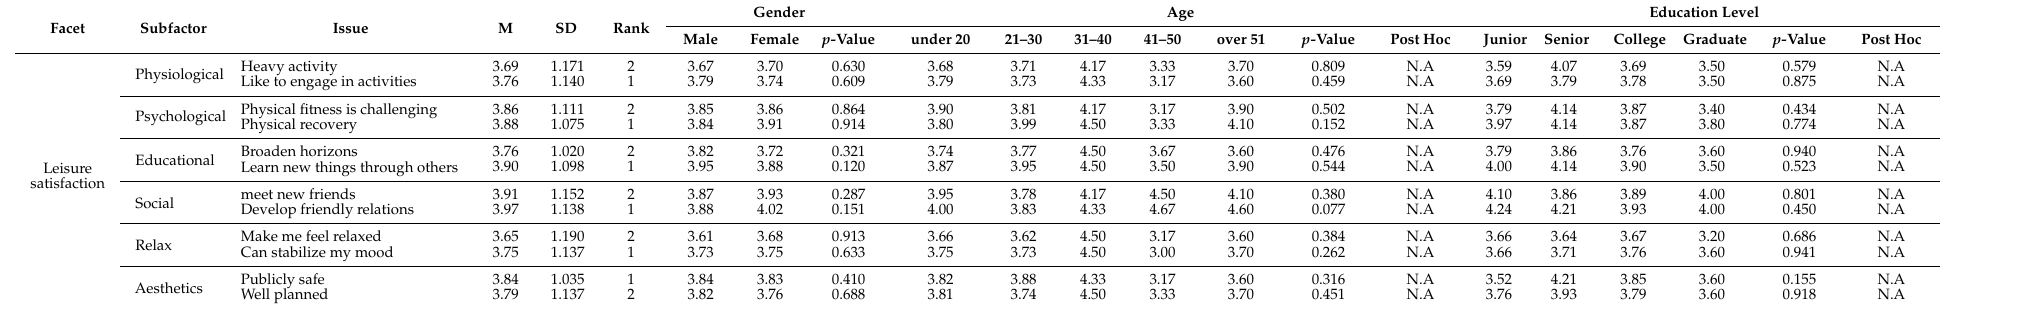
Table 6. Analysis of cognitive differences in leisure